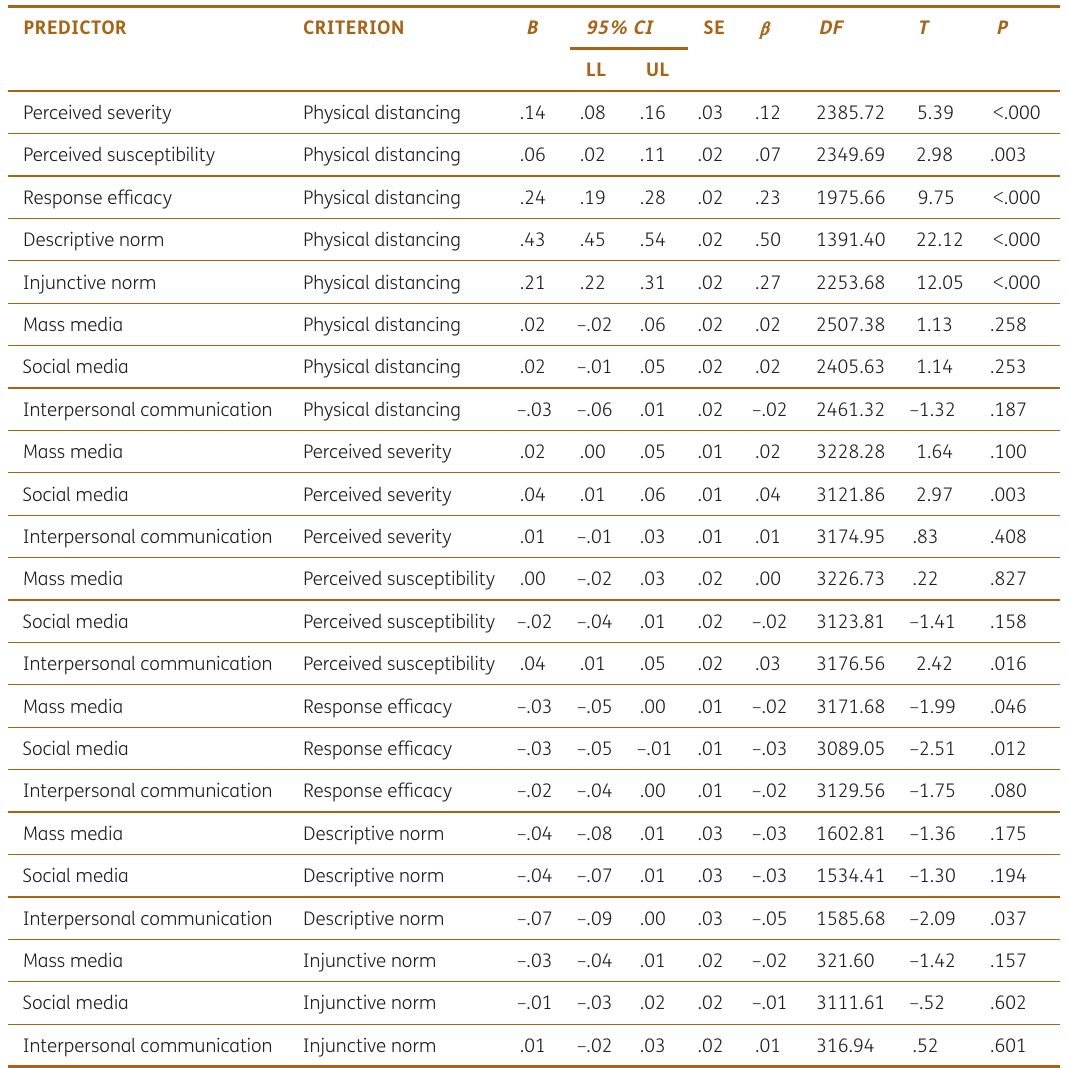
Table 5 Univariate Linear Mixed-Effects Predicting Physical Distancing Behavior in the University Sample.